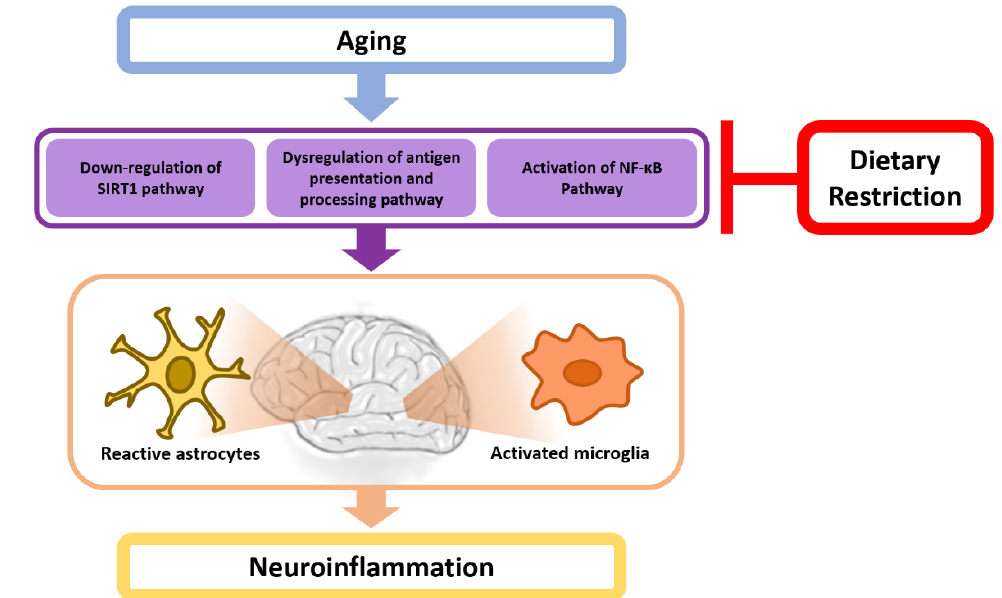
Figure 1. Overview of the potential mechanistic links between age-induced neuroinflammation and dietary restriction. All arrows indicate stimulation/consequences, and red T bar indicates mitigation.